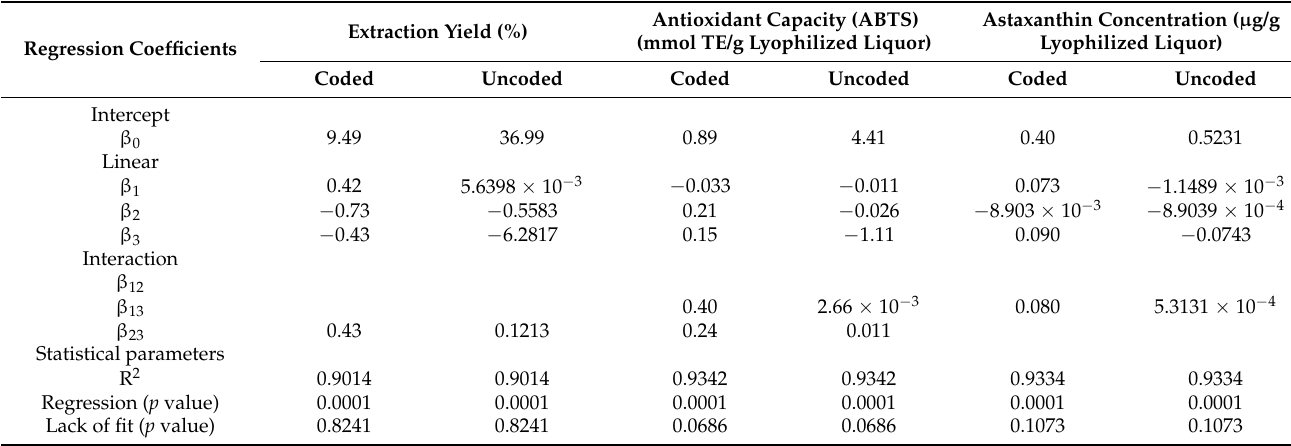
Table 1. Regression coefficients and variance analysis of second-order polynomial models for supercritical CO 2 extraction of lyophilized liquor.